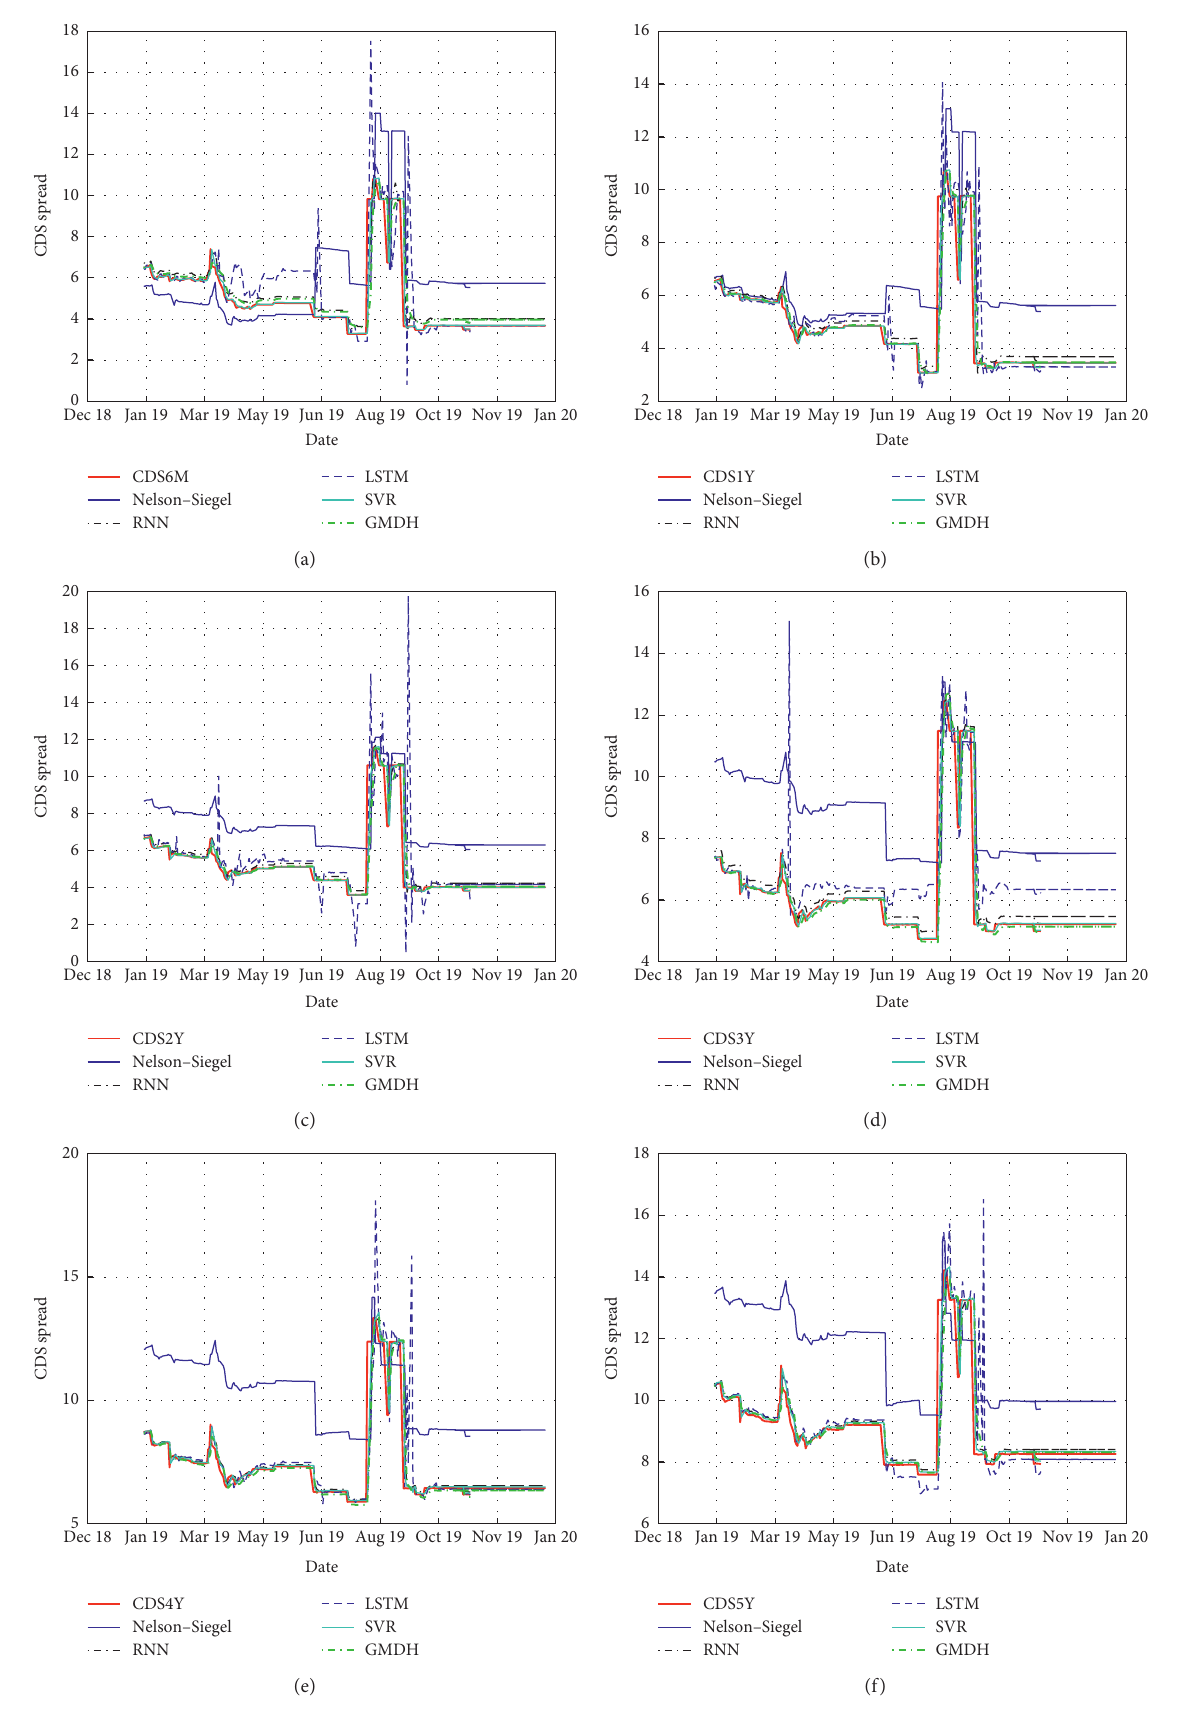
Figure 10: Predictions of each model and target CDS term structure from six months to five years maturity for test dataset 1 with the subperiod 2 training set (case